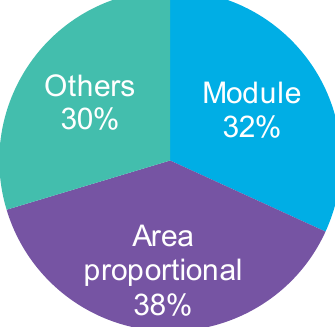
Figure 4. Cost structure of a utility-scale PV project in 2018. Note: Module efficiency for this example project is 17.7%.